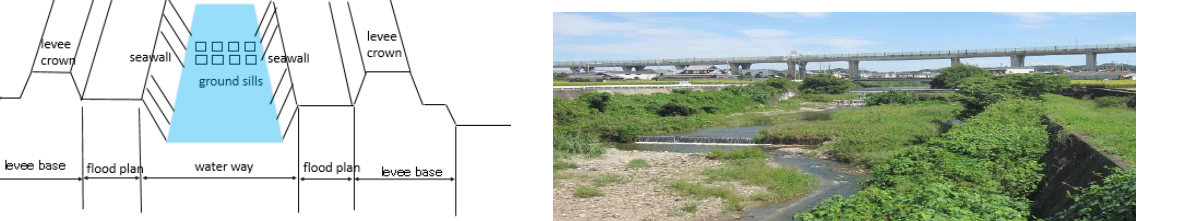
Figure 1. River administration facilities[Yamatogawa River